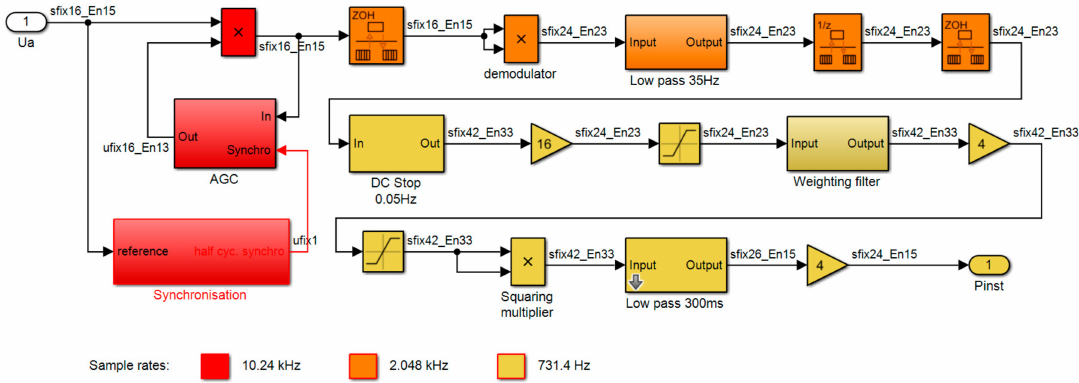
Figure 5. Fixed-point flickermeter Simulink